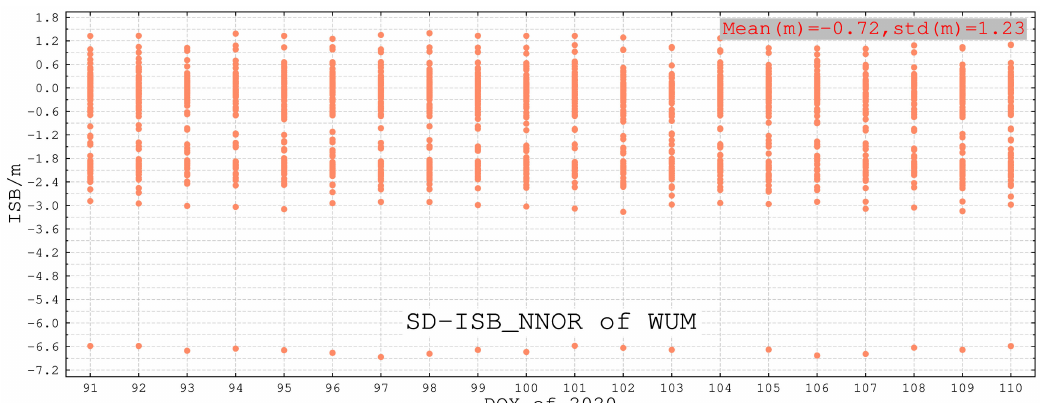
Figure 9. The single di ff erence ISB series of 85 stations by using WUM precise products from DOY 091 to 110, 2020. Reference station: NNOR.